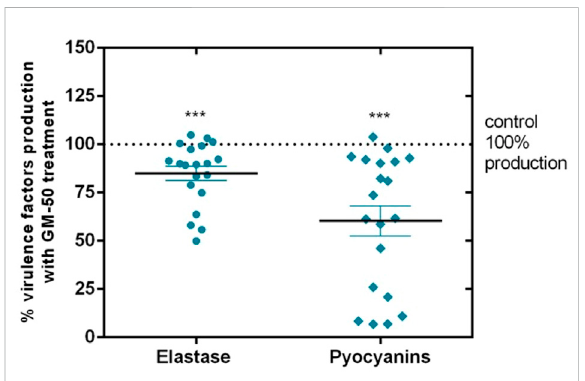
FIGURE 6 Effect of GM-50 on virulence factors expression in P. aeruginosa clinical isolates. P. aeruginosa respiratory tract isolates were cultured (10 6 CFU/ml) in LB with GM-50 (100 µM) or DMSO 0.05% (vehicle) for 24 h at 37 ° C. After incubation, supernatants were used to quantify elastase release by Elastin- Congo red assay or pyocyanin production by the chloroform-HCl method. Pyocyanin and elastase obtained with strains cultured with DMSO 0.05% were arbitrarily assigned 100% production and were used as control. Data are represented as mean ± SEM, n = 3 experiments for each clinical isolate. *** p < 0.001 vs .